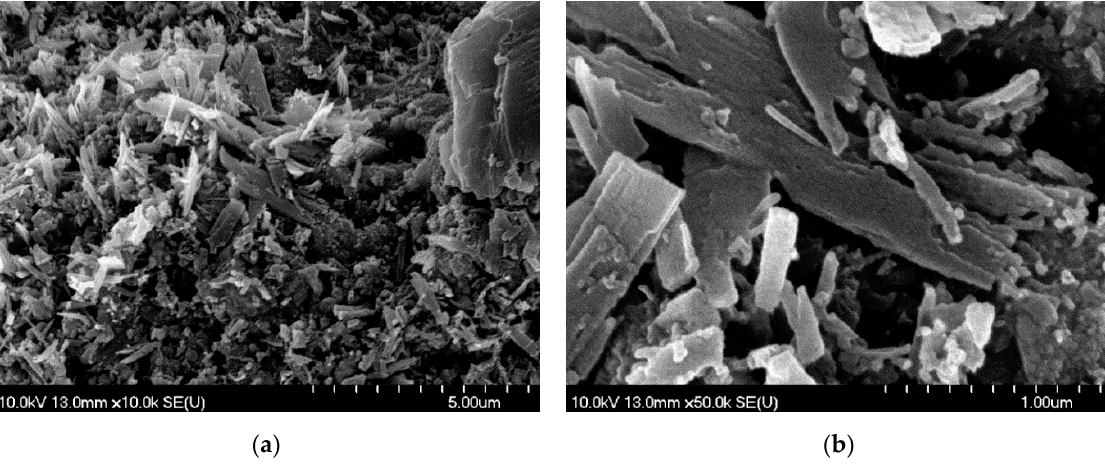
Figure 9. SEM pictures of the meloxicam pastille surface after PLAL (at 1.5 J/cm 2 fluence): ( a ) the ablated surface of the pastille covered with needle-like and laminar particles. M: 10k; ( b ) magnified central region of ( a ). M: 50k.